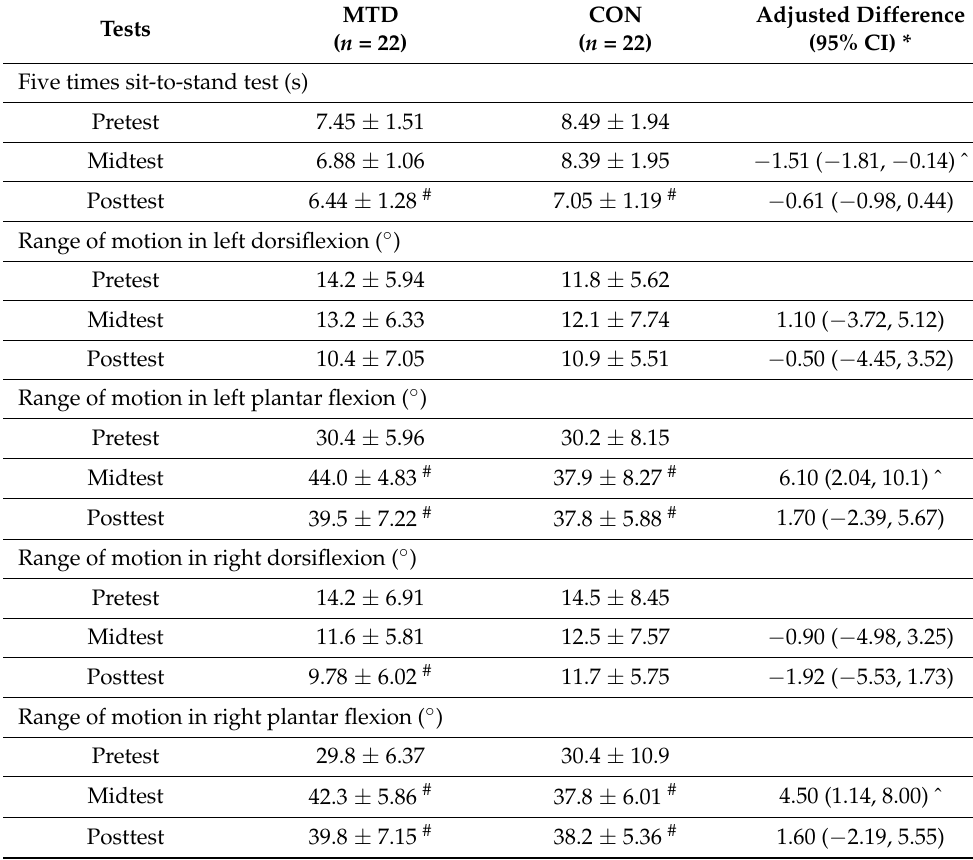
Table 2. Between and within-group differences in ankle function-related parameters.